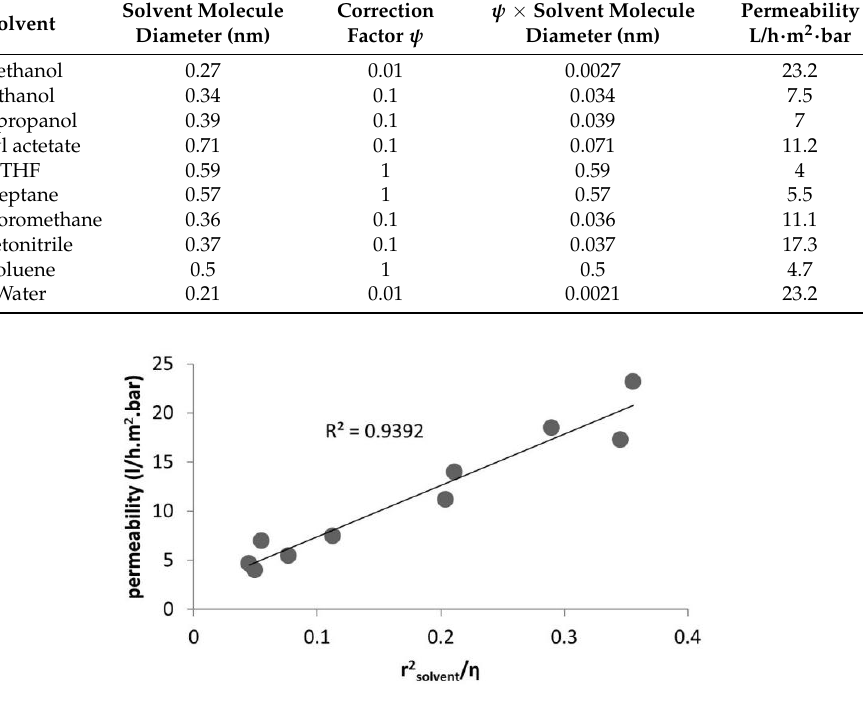
Figure 5. Solvent permeability versus 𝑟 solvent2 /𝜂 studied by [40].